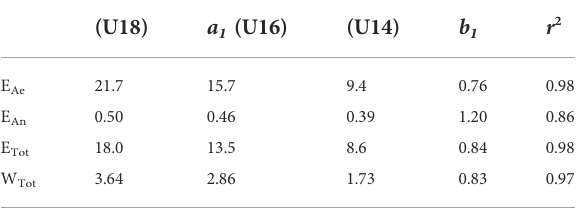
TABLE 4 Allometric coef fi cients resulting from simple model associated with the energy amount derived from aerobic and anaerobic pathways and total mechanical work produced.